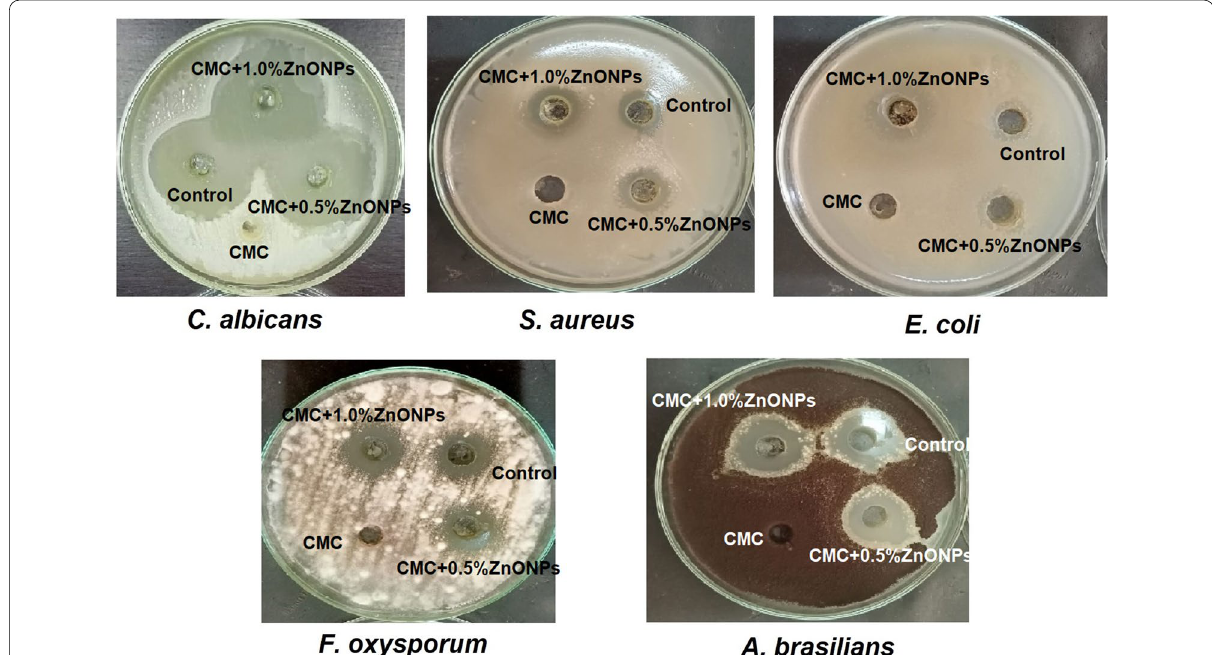
Fig. 7 Photograph of the antibacterial and antifungal activities of the prepared films against different pathogenic bacterial strains, unicellular fungi, and plant pathogenic fungi